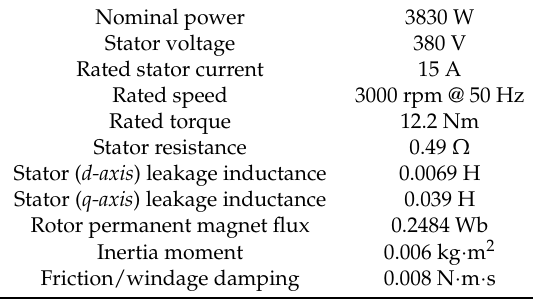
Table A2. Rating and parameters of the PMSG.